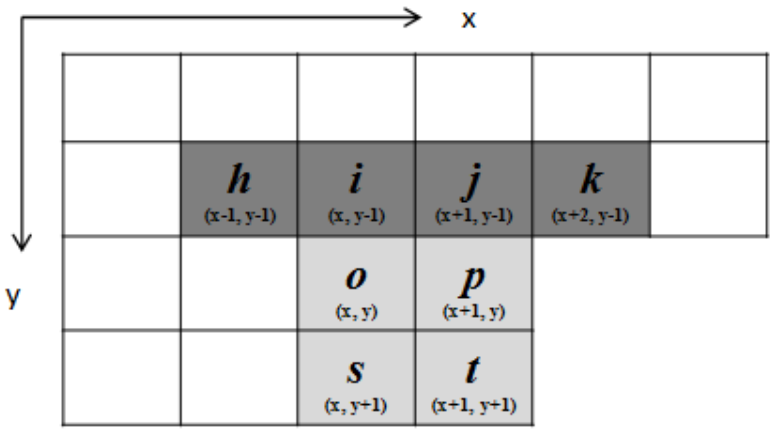
Figure 2. Block-based scan mask of the proposed